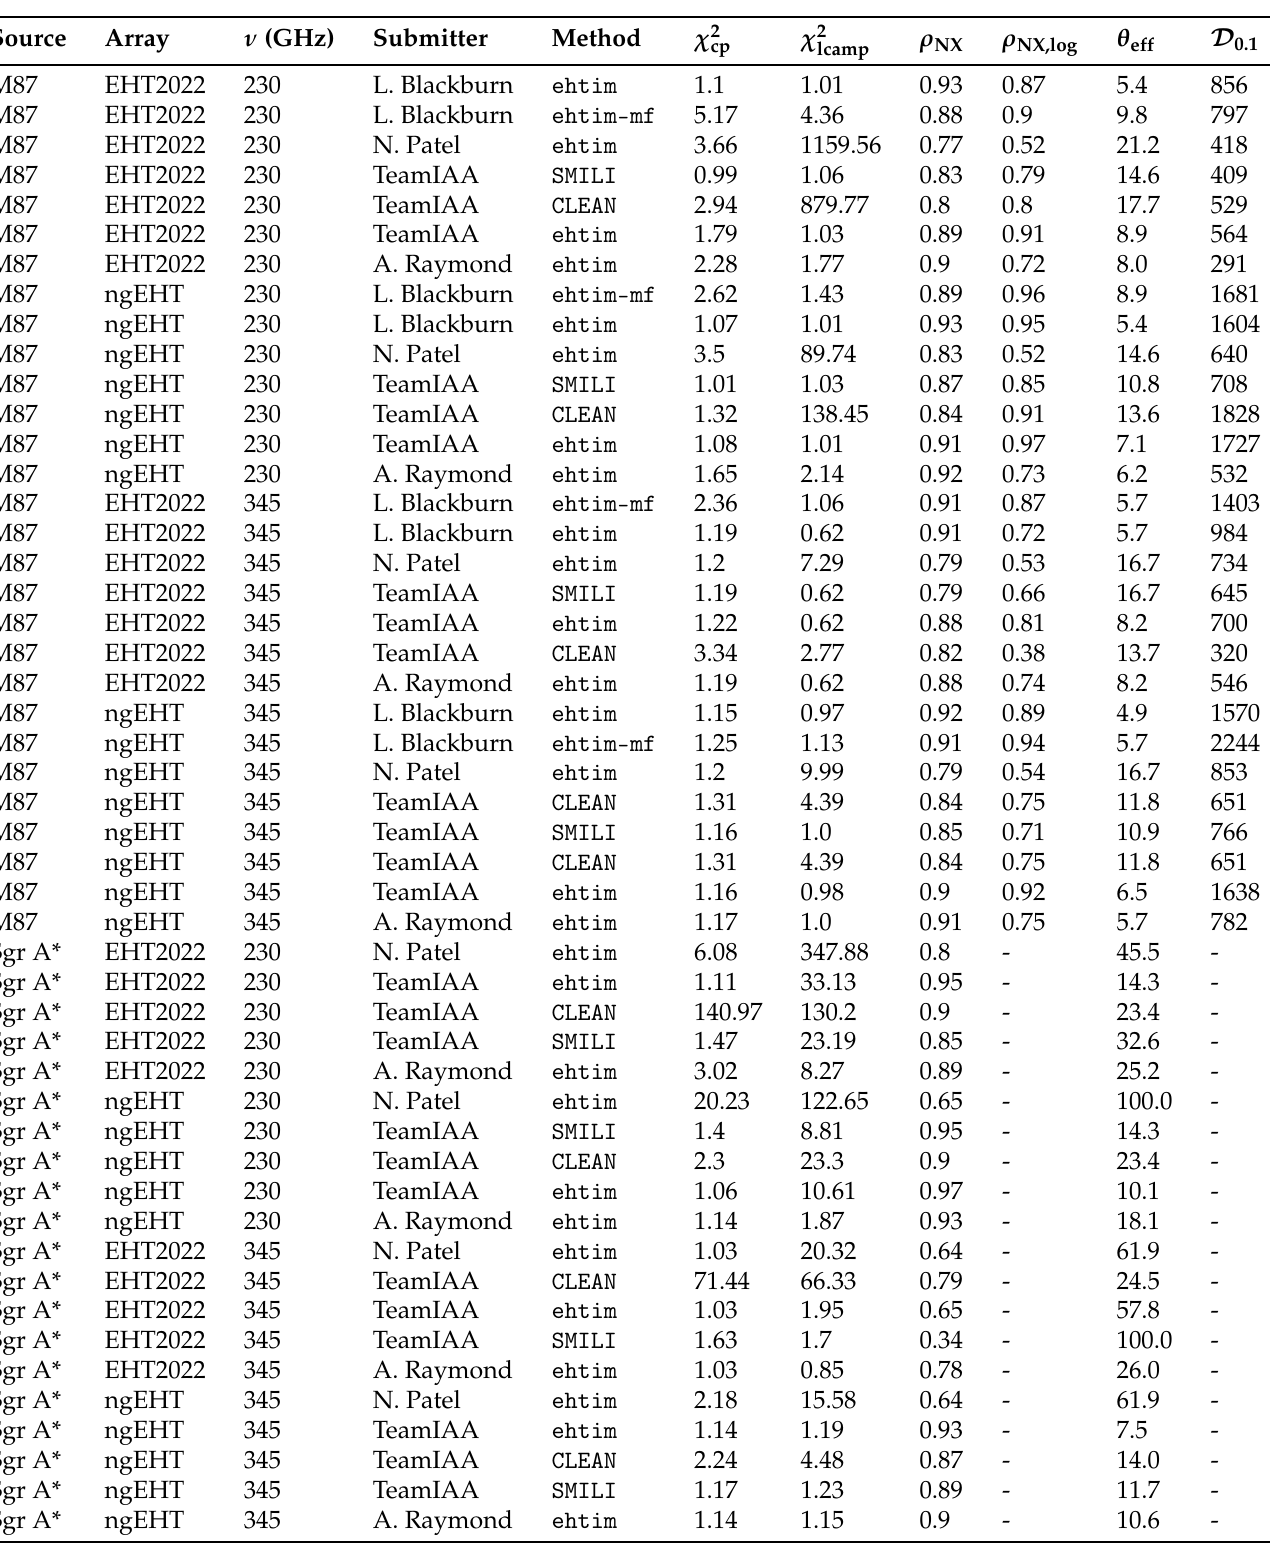
Table 1. Reconstruction quality metrics for Challenge